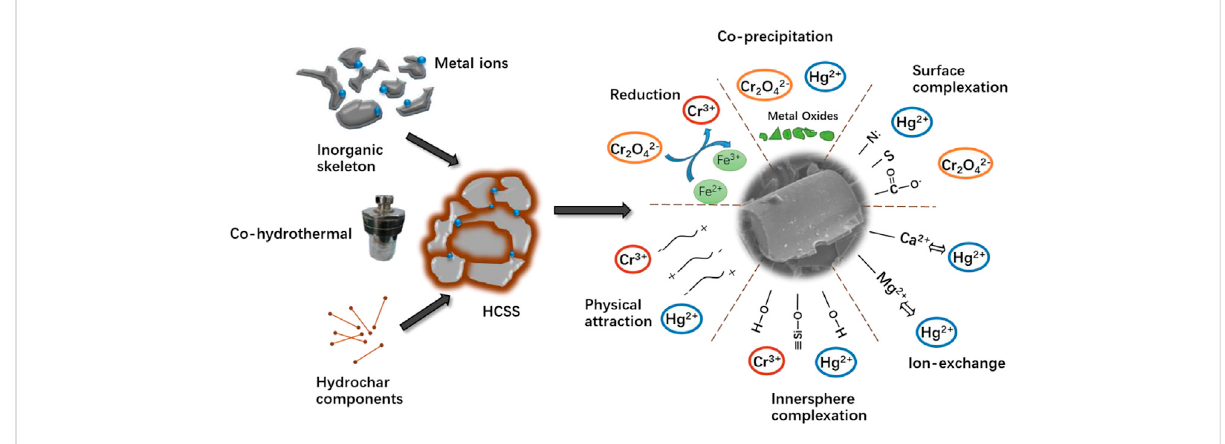
FIGURE 9 Conceptual sketch of Hg (II) or Cr (VI) removal by